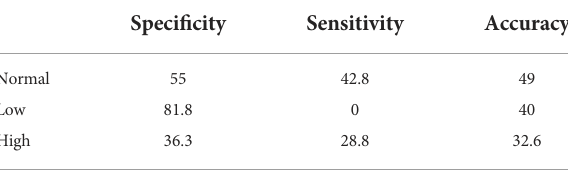
TABLE 2 Confusion Matrix Summary for normal, low, and high heart rate obtained from the PPG